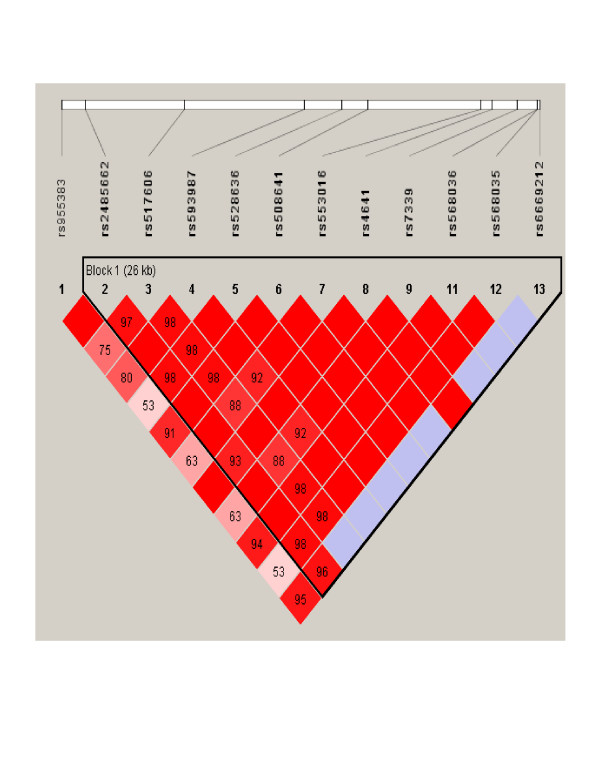
Linkage disequilibrium plot demonstrates the inheritance of tagged SNPs as a single block within the LMNA gene.